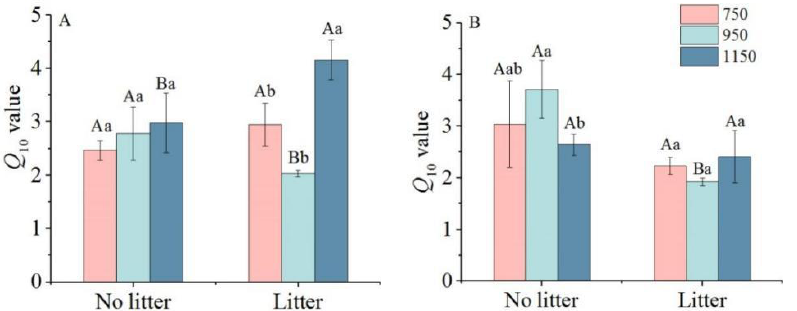
Figure 2. Temperature sensitivity ( Q 10 ) of SOC in the control (no litter) and treated (litter input) soils from different elevations (750 m, 950 m, 1150 m) during the 0 – 37 days ( A ) and 37 – 97 days ( B ) incu- bation period, respectively. Values are expressed as the means ± SE ( n = 4). Lower case letters and the capital letters indicate significant differences between elevations and litter, respectively ( p < 0.05).